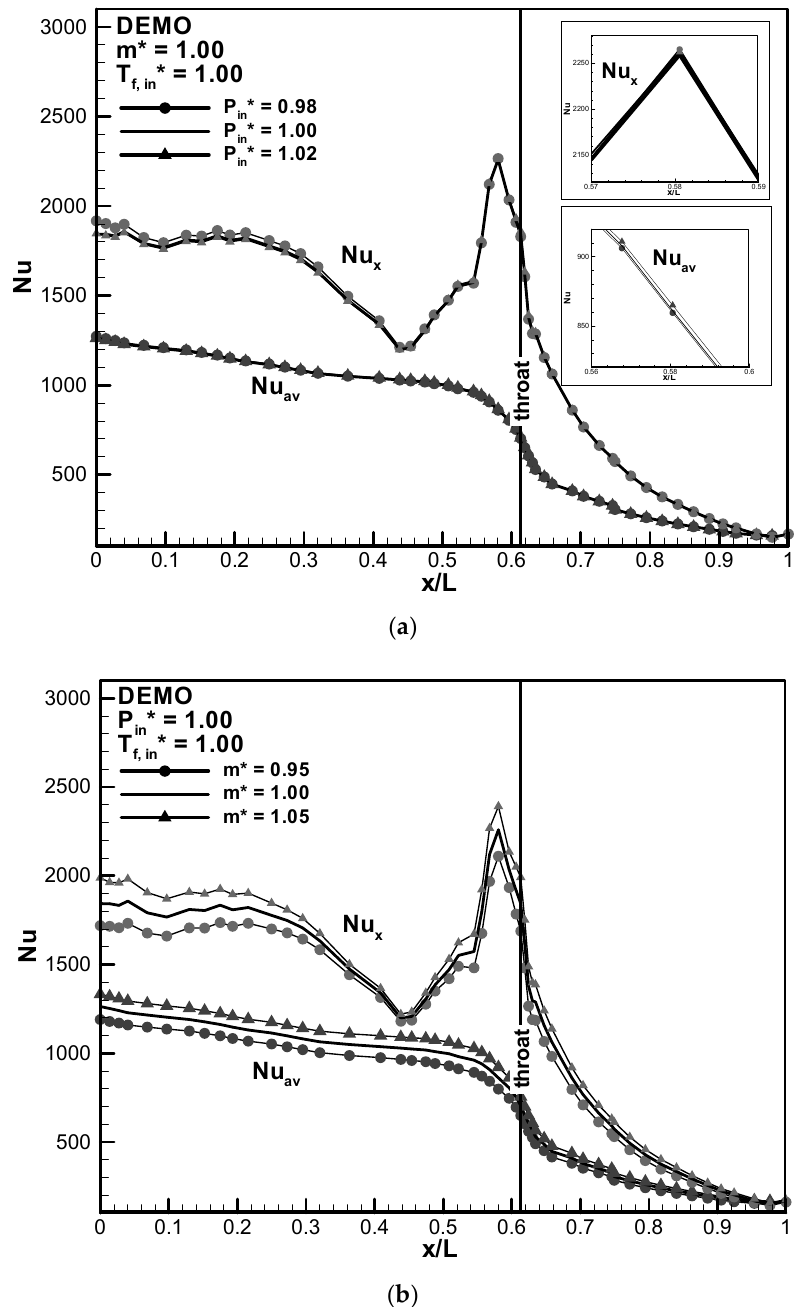
Figure 21. Axial profiles of local and average convective Nusselt number (runs 1, 5-8): ( a ) effects of inlet pressure; ( b ) effects of mass-flow rate.